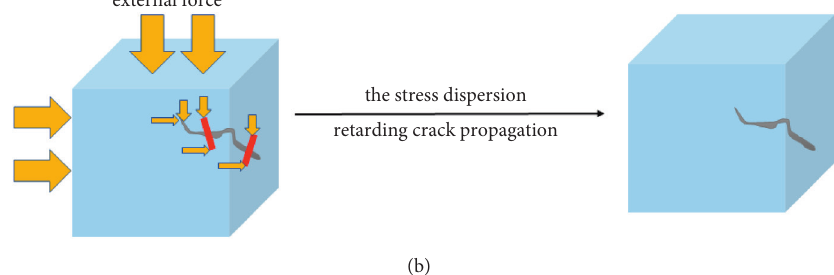
Figure 10: Stress distribution of slag (a) without whiskers and (b) with